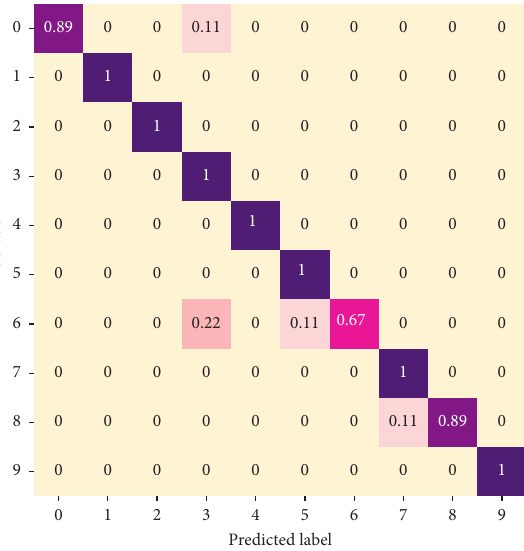
Figure 20: Confusion matrix for the test